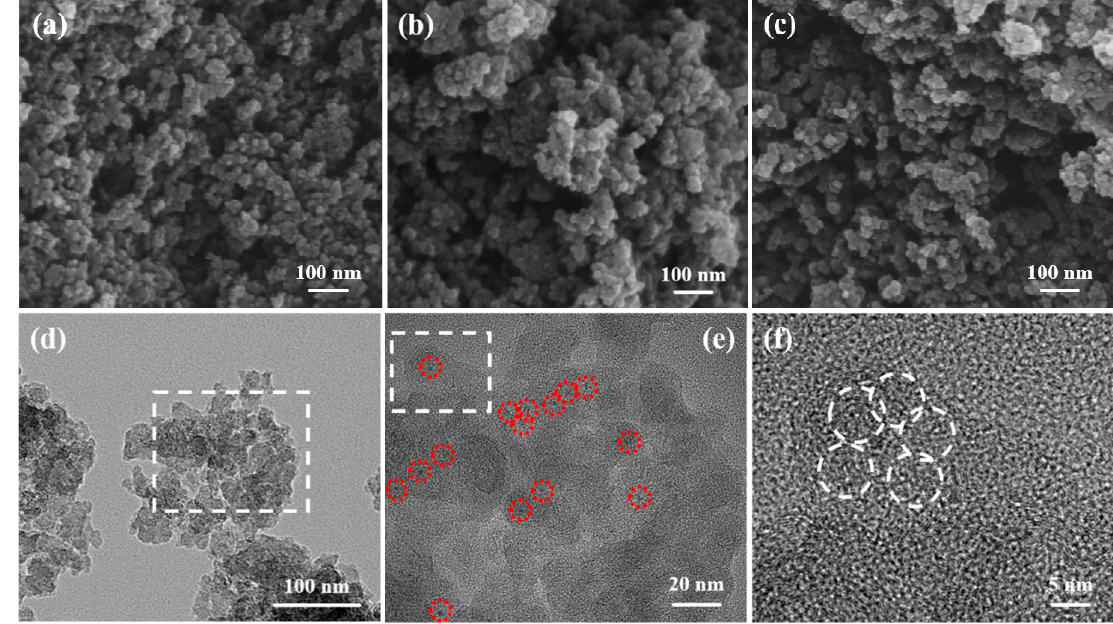
Figure 1. SEM images of ( a ) 600 MoC-BN/C, ( b ) 700 MoC-BN/C, and ( c ) 800 MoC-BN/C, ( d ) low-resolution TEM image of 800 MoC-BN/C, ( e ) and ( f ) high-resolution TEM images of 800 MoC-BN/C. The same X-ray diffraction (XRD) peaks were observed in all catalysts (Figure 2a). The broad XRD peak at 23.4° was assigned to the (002) plane of graphitic carbon, highlighting the low crystallinity of the carbon. The XRD peaks at 36.4°, 42.2°, 61.4°, and 73.6° were attributed to the (111), (200), (220), and (311) planes for molybdenum carbide (MoC), respectively. Additionally, the Mo 2 C peak was identified at 39.3° in only 800 MoC-BN/C. The crystallographic results confirmed that the MoC-BN/C catalysts consisted of the molybdenum carbide nanoparticles in the graphitic carbon support.